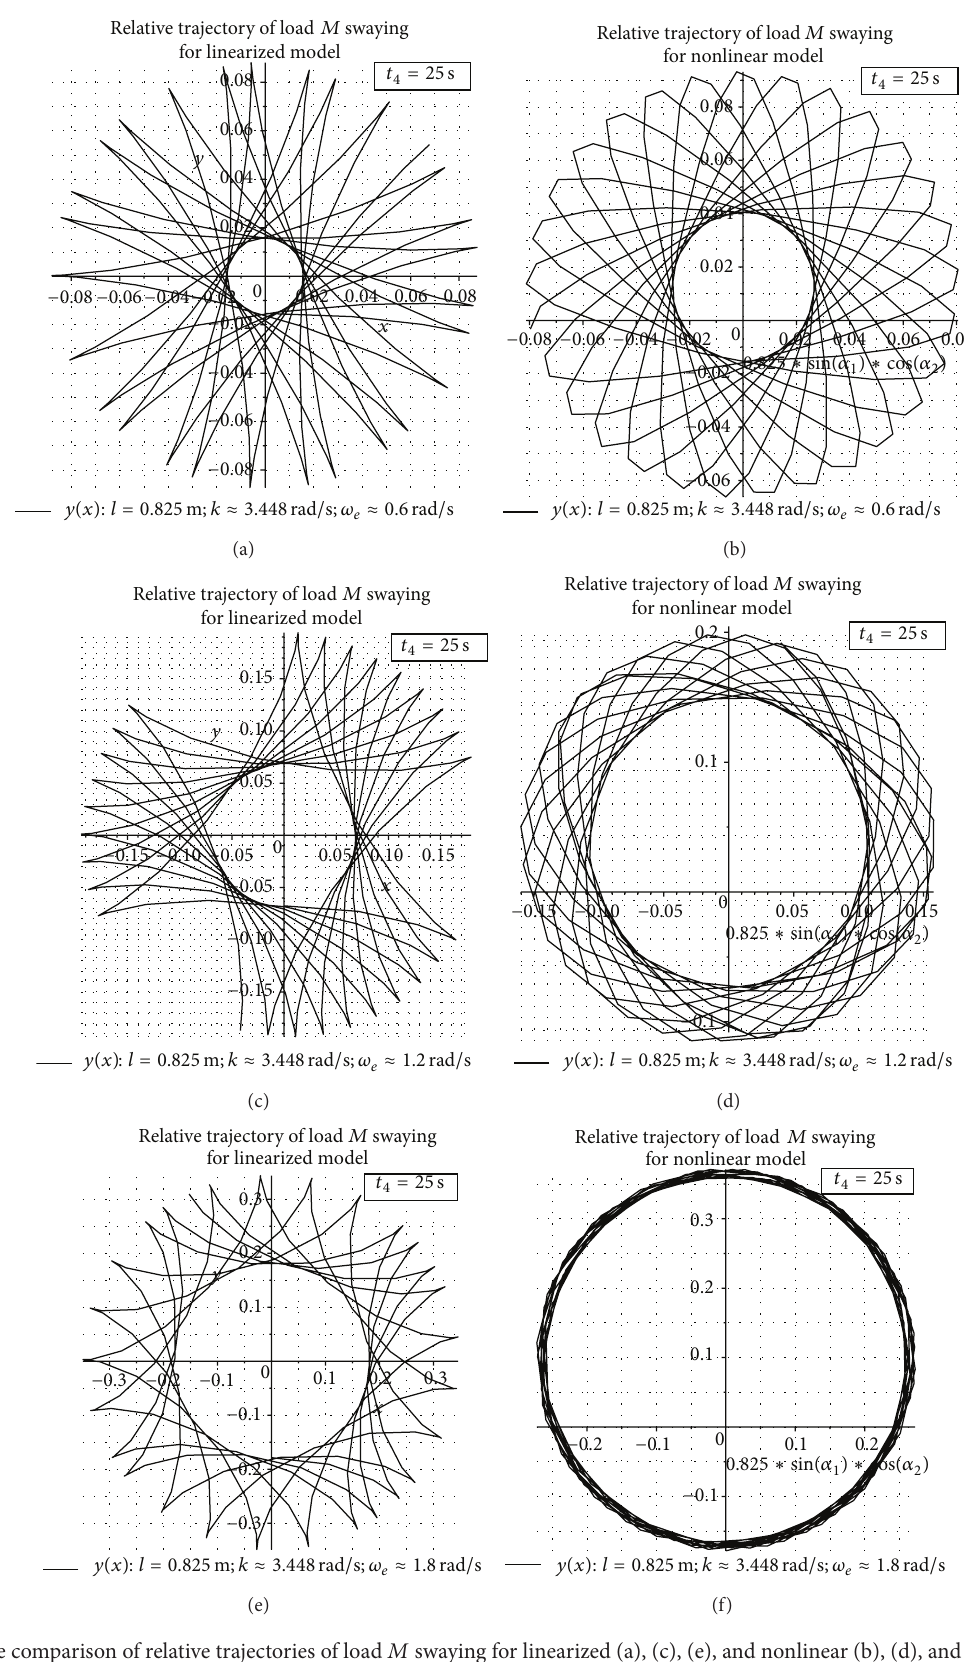
Figure 17: The comparison of relative trajectories of load 𝑀 swaying for linearized (a), (c), (e), and nonlinear (b), (d), and (f) models in the cases of 𝜔 𝑒 /𝜔 𝑒0 ≈ 2.871 (a-b), 𝜔 𝑒 /𝜔 𝑒0 ≈ 5.742 (c-d), and 𝜔 𝑒 /𝜔 𝑒0 ≈ 8.612